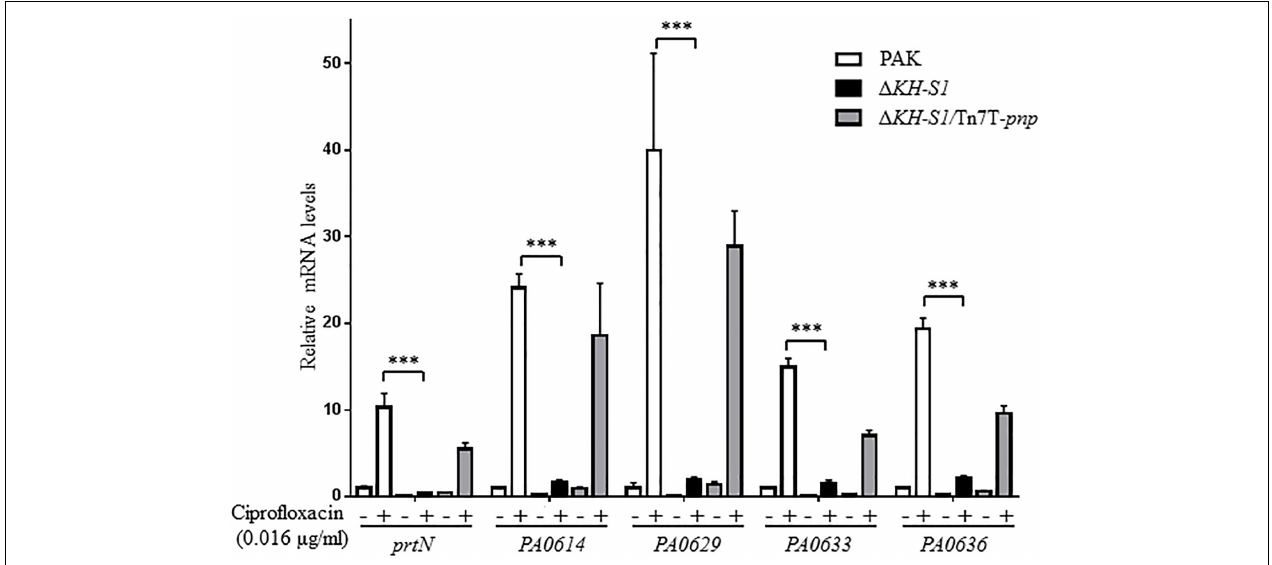
FIGURE 2 | Expression levels of pyocin biosynthesis genes in the (cid:49) KH-S1 mutant. PAK, (cid:49) KH-S1 and the complemented strain were grown to an OD 600 of 0.8–1.0 at 37 ◦ C with or without 0.016 µ g/ml ciprofloxacin, followed by RNA extraction. The mRNA levels of prtN , PA0614 , PA0629 , PA0633, and PA0636 were determined by real-time PCR with rpsL as the internal control. ∗∗∗ p < 0.001 by Student’s t -test.